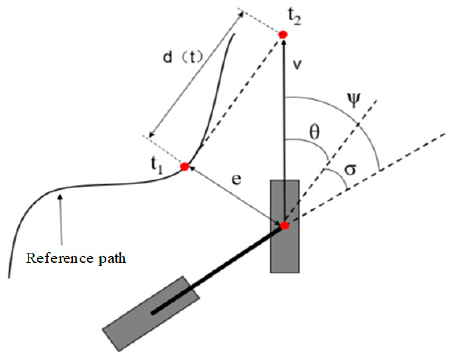
Figure 16. Schematic diagram of the Stanley algorithm.